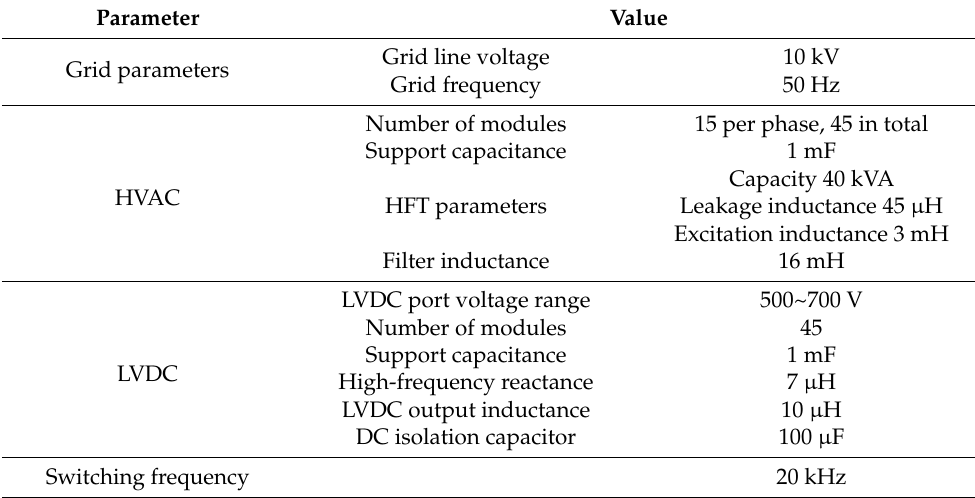
Table 1. Simulation